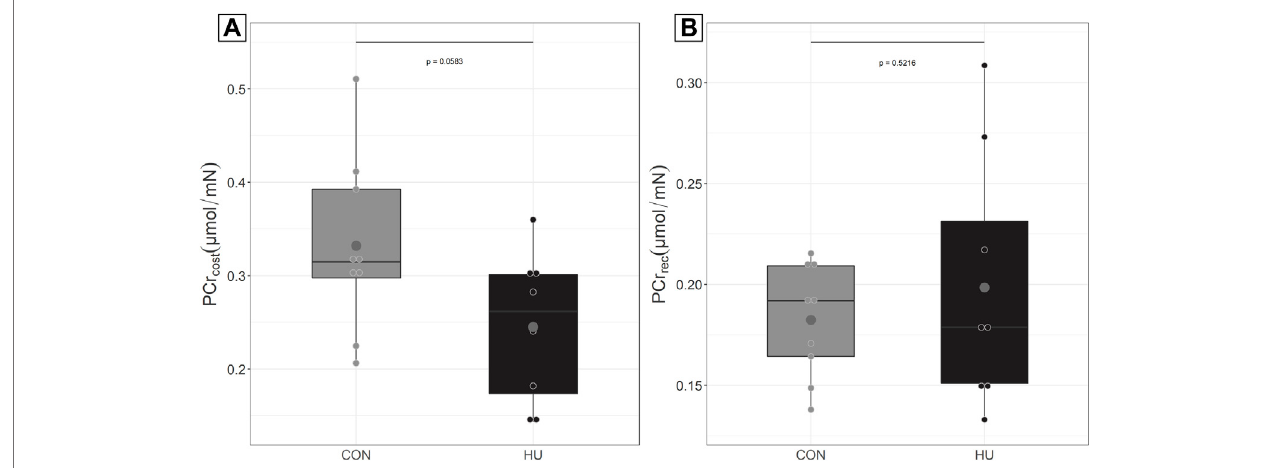
FIGURE3| Time dependent changesin speci fi cpeak force throughout themoderate exercise inCON(grey, n = 9) and HU-treated mice (black, n =8). Resultsare presented as means ± SEM.